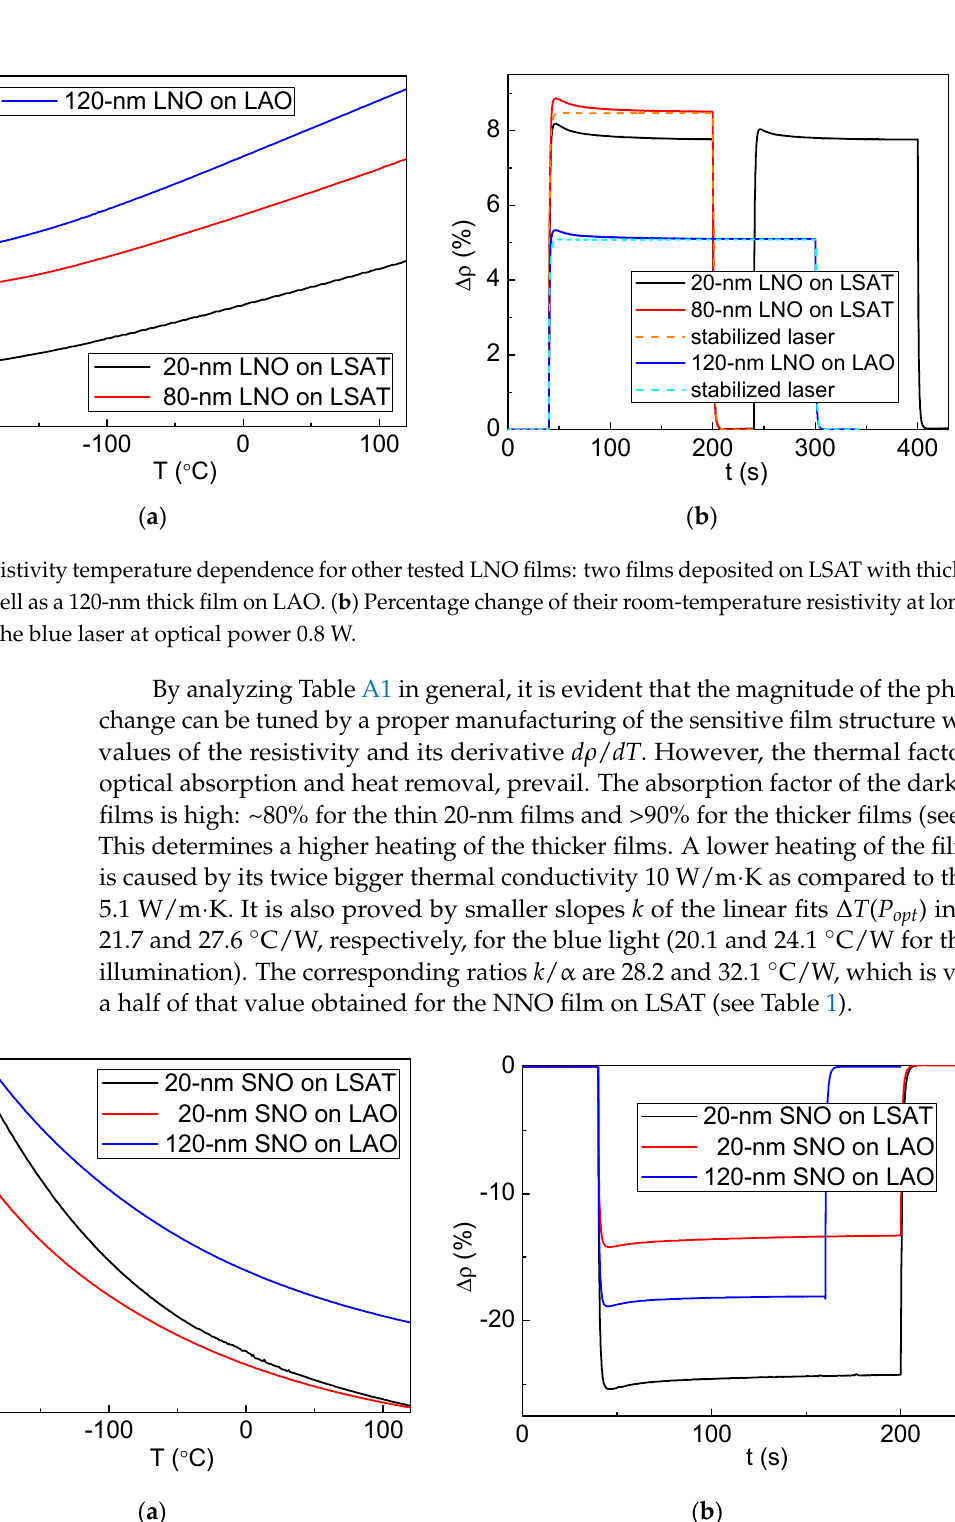
Figure A2. ( a ) Resistivity temperature dependence for other tested NNO films: two 20-nm thick films deposited on LSAT and LAO and a 120-nm thick film on LAO. ( b ) Percentage change of their room-temperature resistivity at periodical 60-s illumination by the blue laser at optical power 0.8 W.